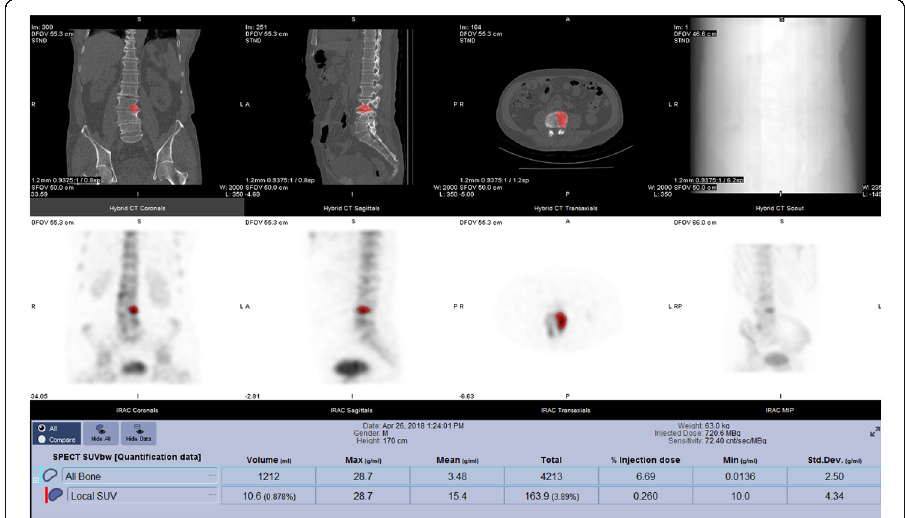
Fig. 2 Quantitative bone SPECT of a 69-year-old female patient with a right hip prosthesis who is experiencing bone pain. Data show degenerative changes at the L3 and L4 endplates and elevated